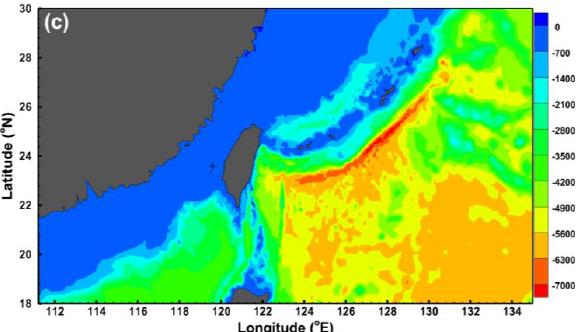
Figure 4. ( a ) Location, ( b ) unstructured grid and ( c ) bathymetry of the computational domain.